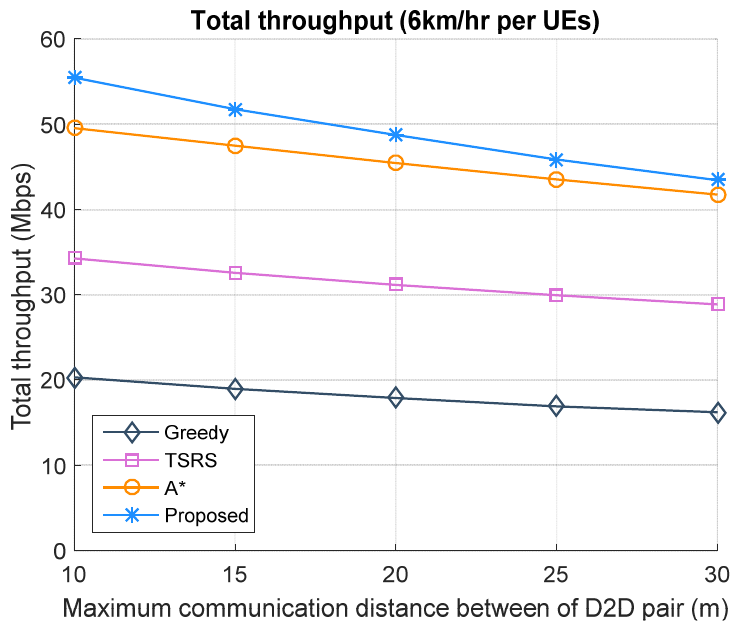
Figure 13. Throughput vs. D2D link length.